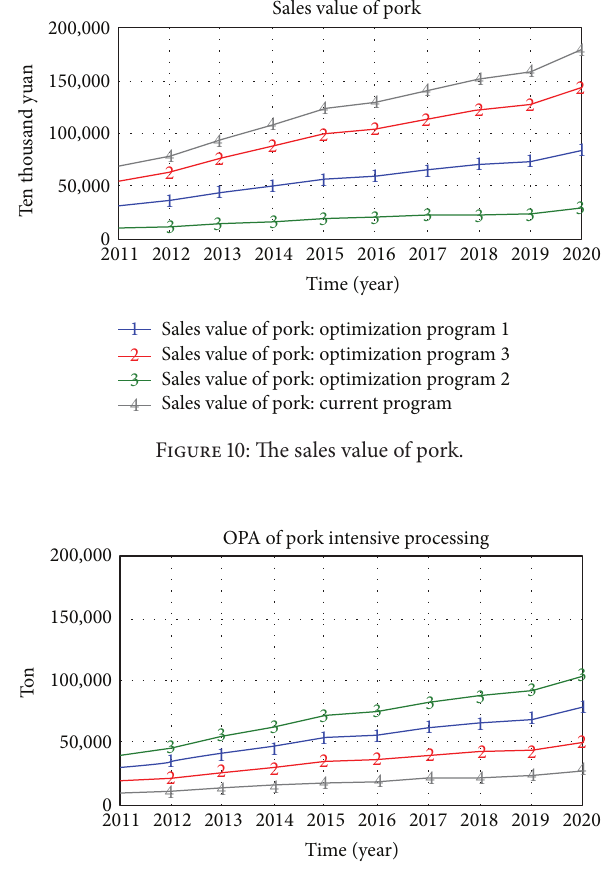
proportion should be constrained to reduce the high energy